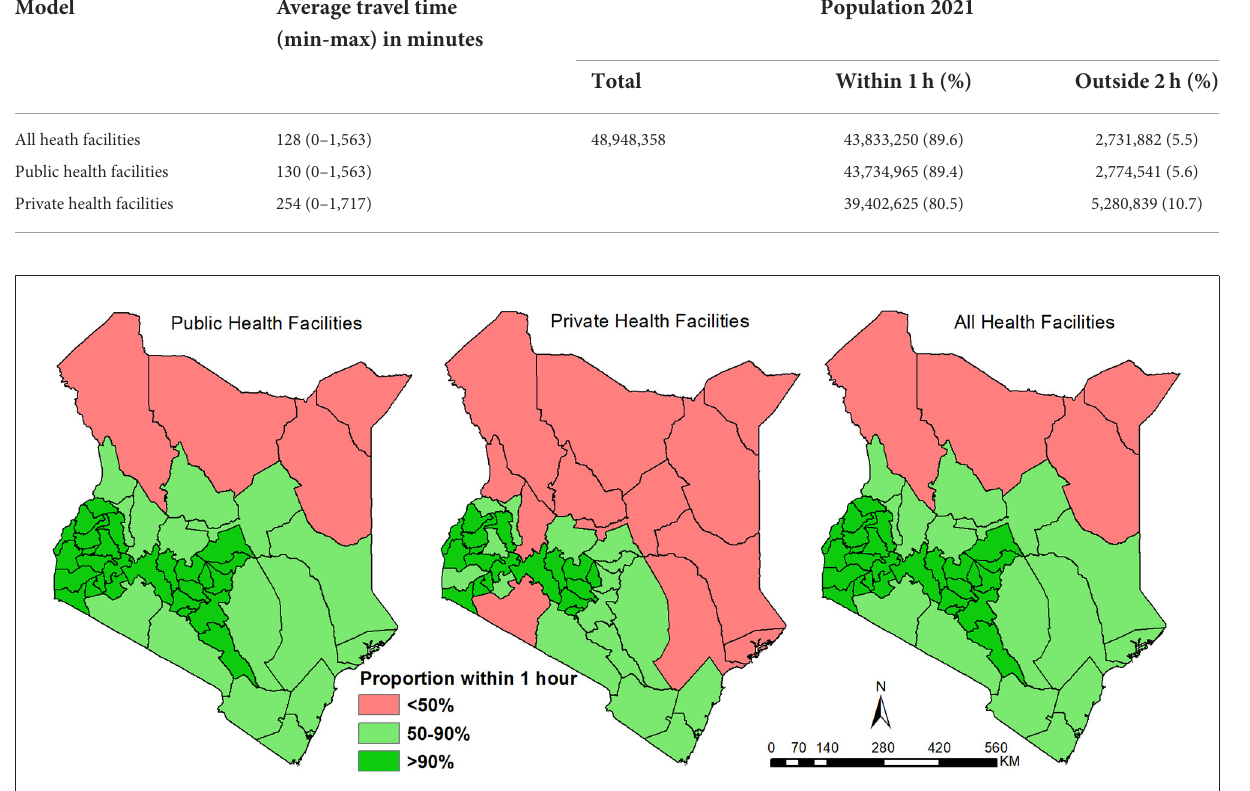
FIGURE3 Proportion of population within a 1-h travel time of a public, private, and combined (public and private) in 2021 disaggregated by county.